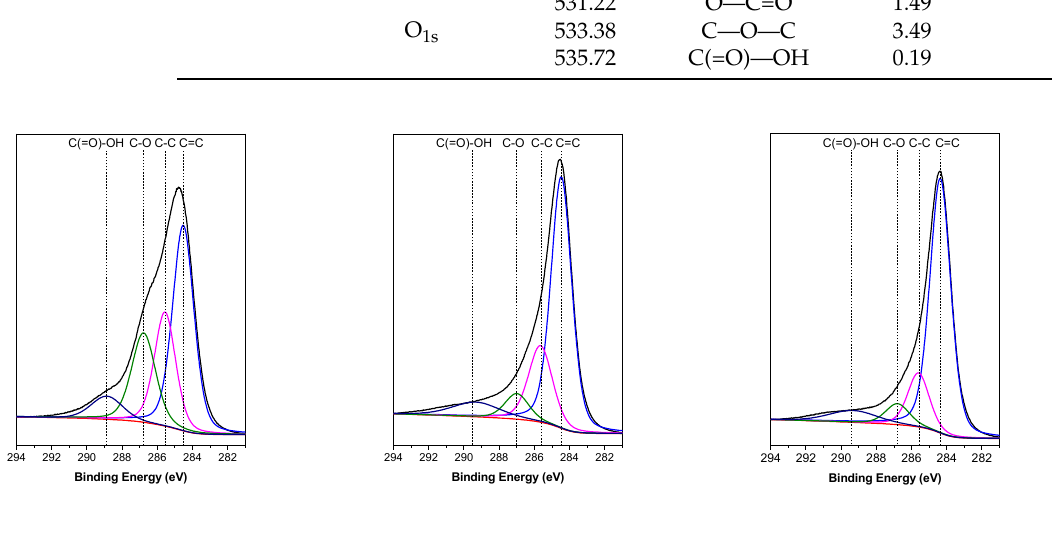
Figure 3. Contributions of functional groups of C1s photoelectric lines obtained from X-ray photoelectron spectroscopy (XPS) for GO ( a ), TRGO 600 ( b ), and TRGO 1000 ( c ).